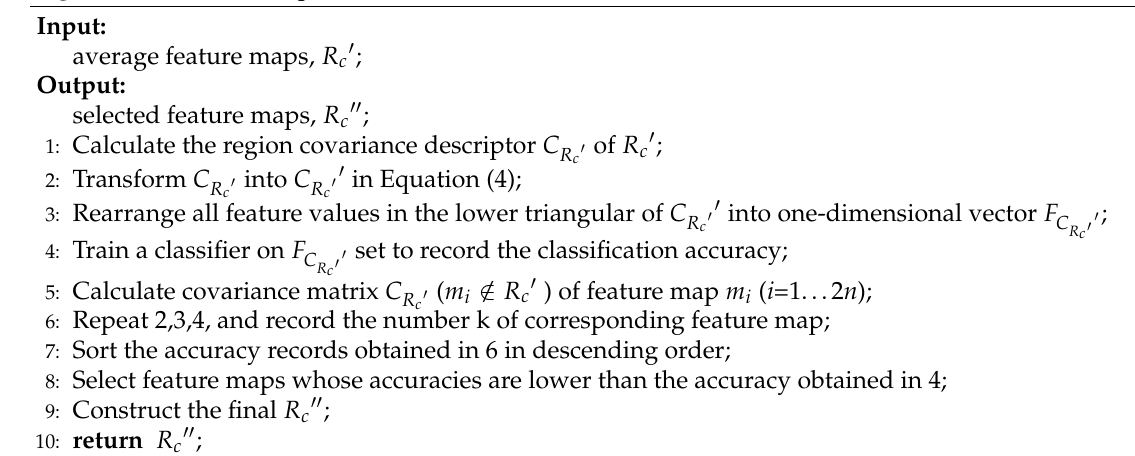
Algorithm 1 Feature Maps